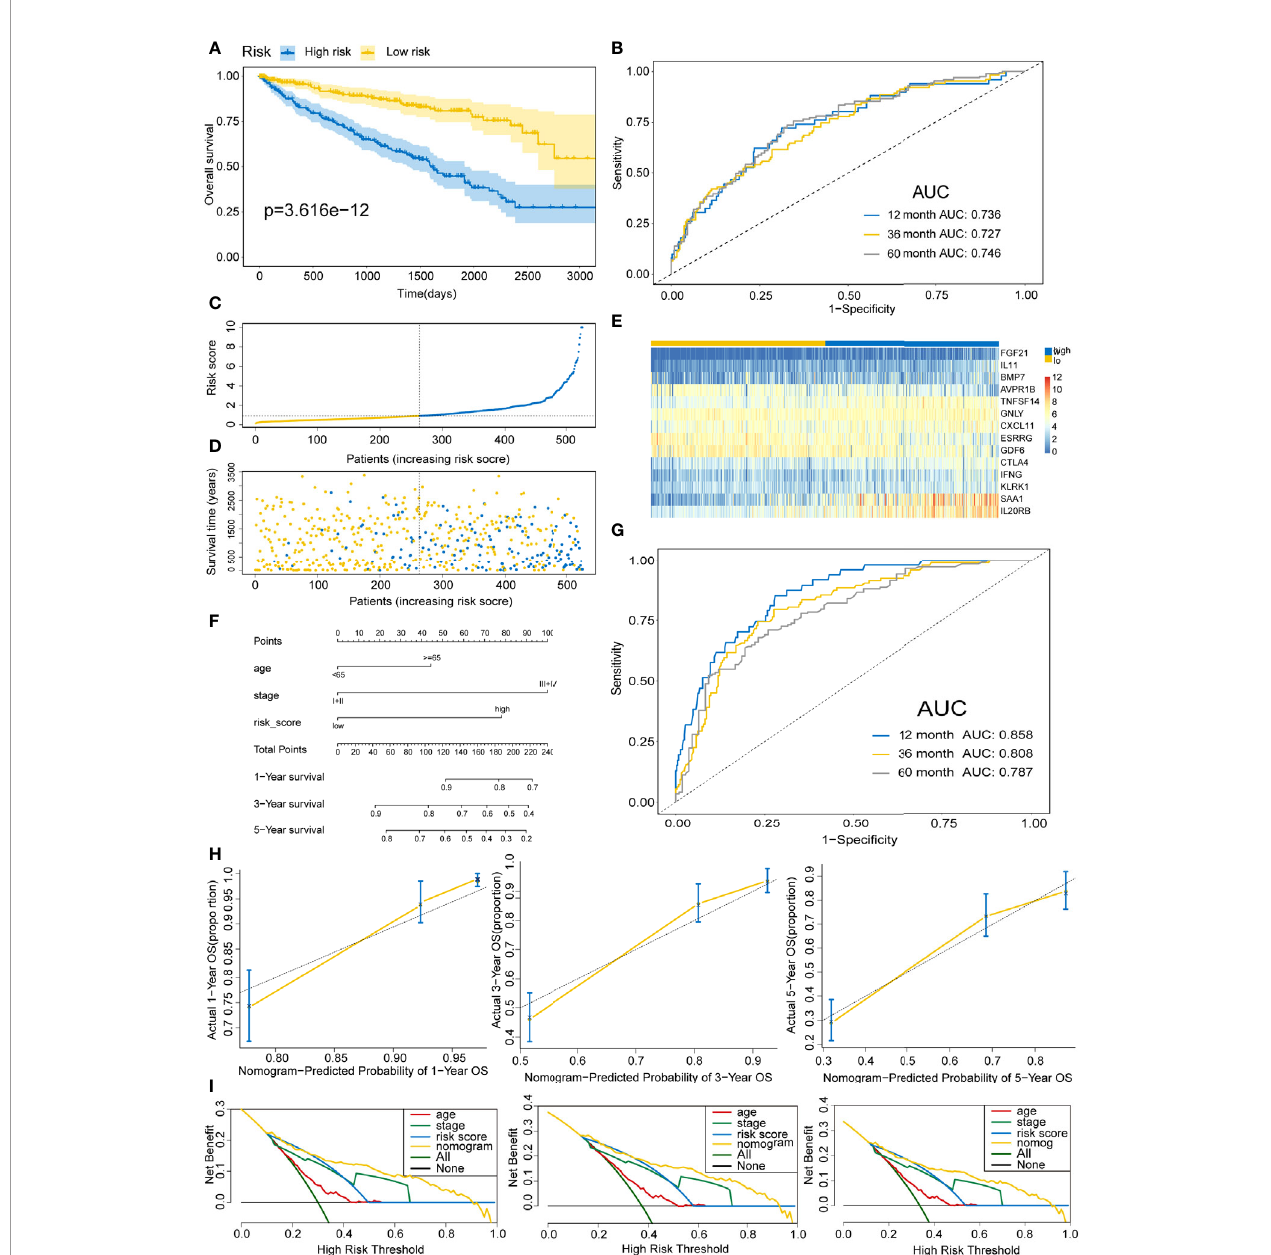
FIGURE 6 | Validating the immune risk score prognostic predictive model for the entire set. (A) Kaplan – Meier curves of the OS outcomes in the entire cohort divided as high- and low-risk score groups. (B) Time-dependent ROC curves for prediction of 1-, 3-, and 5-year survival outcomes using this signature. (C) Risk score distributions for the entire cohort. (D) Vital statuses for high- and low-risk group patients. (E) Expression patterns for 14 immune-associated genes in the high- and low-risk score cohorts. (F) Nomogram for the prediction of the probability of 1-, 3-, and 5-year OS outcomes in the entire cohort. Risk scores and other independent prognostic factors were incorporated into the model. (G) Time-dependent ROC curves for prediction of 1-, 3-, and 5-year survival outcomes using the nomogram. (H) Calibration plot of nomogram in the training cohort according to the agreement between observed and predicted 1-, 3-, and 5-year outcomes. The models ’ ideal performance is shown by the dashed lines. (I) Decision curve analysis for 1-, 3-, and 5-year risks using the nomogram. Black line represents the hypothesis that no patient died after 1-, 3-, and